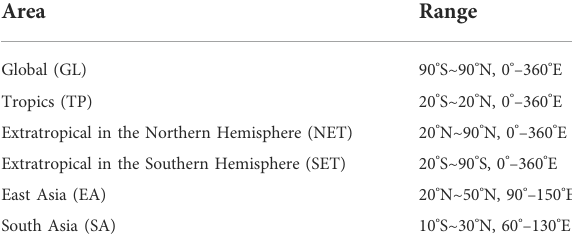
TABLE 1 The evaluation area range and